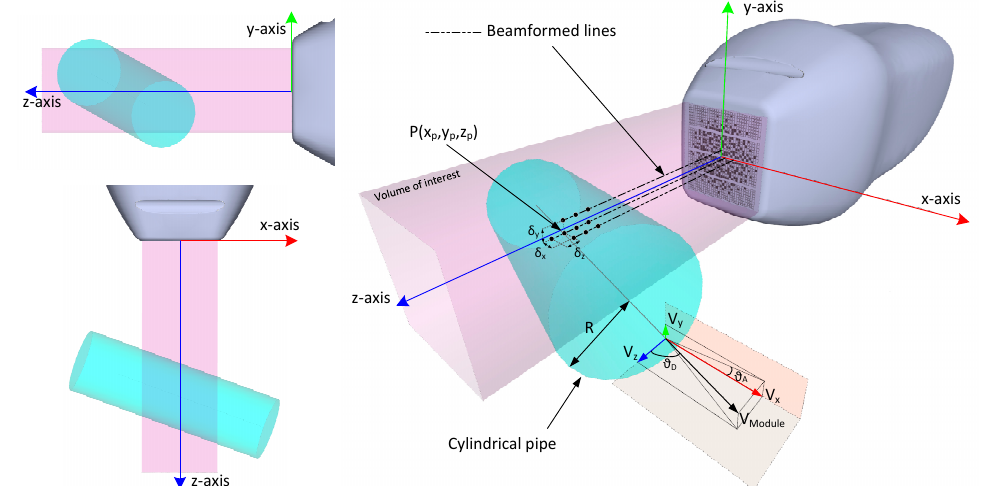
Figure 1. Reference system for simulations and acquisitions. The volume of interest investigated by the 2-D plane wave is highlighted in light pink. The cylindrical pipe (light green) direction is defined by the beam-to-flow Doppler angle, ϑ D , and the azimuth rotation angle, ϑ A .